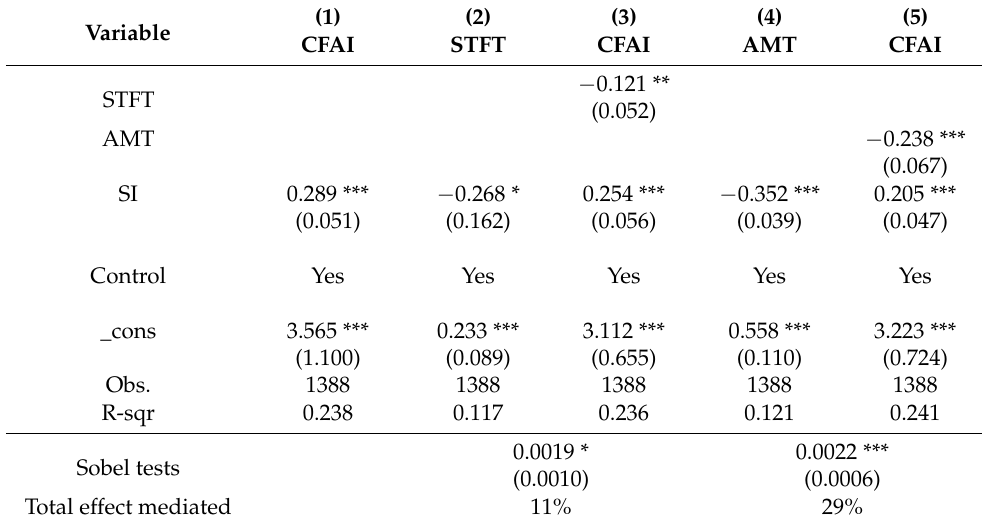
Table 3. Mediating effects of STFT and AMT adoption on the impact of SI on CFAI.